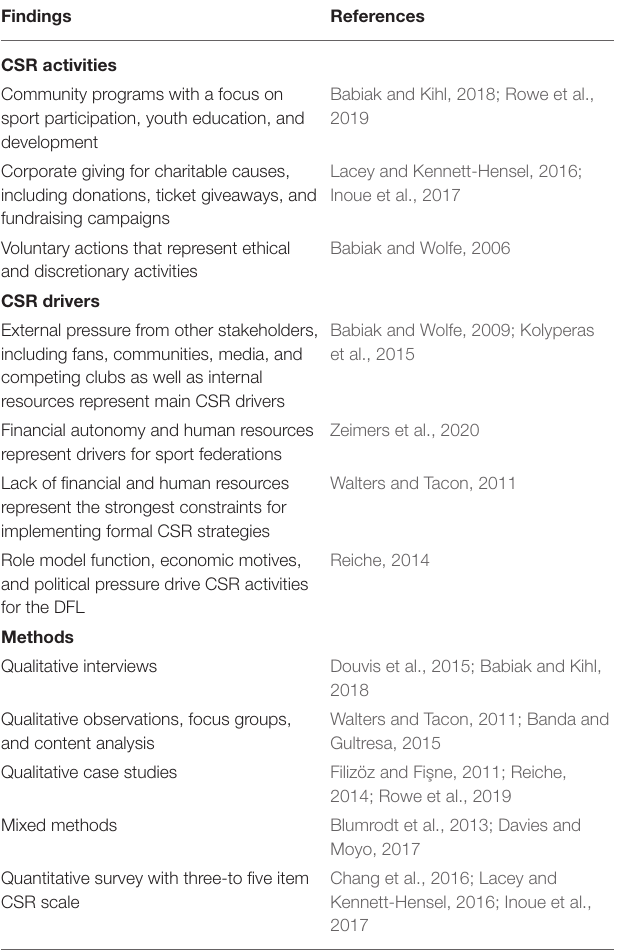
TABLE 1 | Summary of researched corporate social responsibility (CSR) activities, drivers, and the employed research